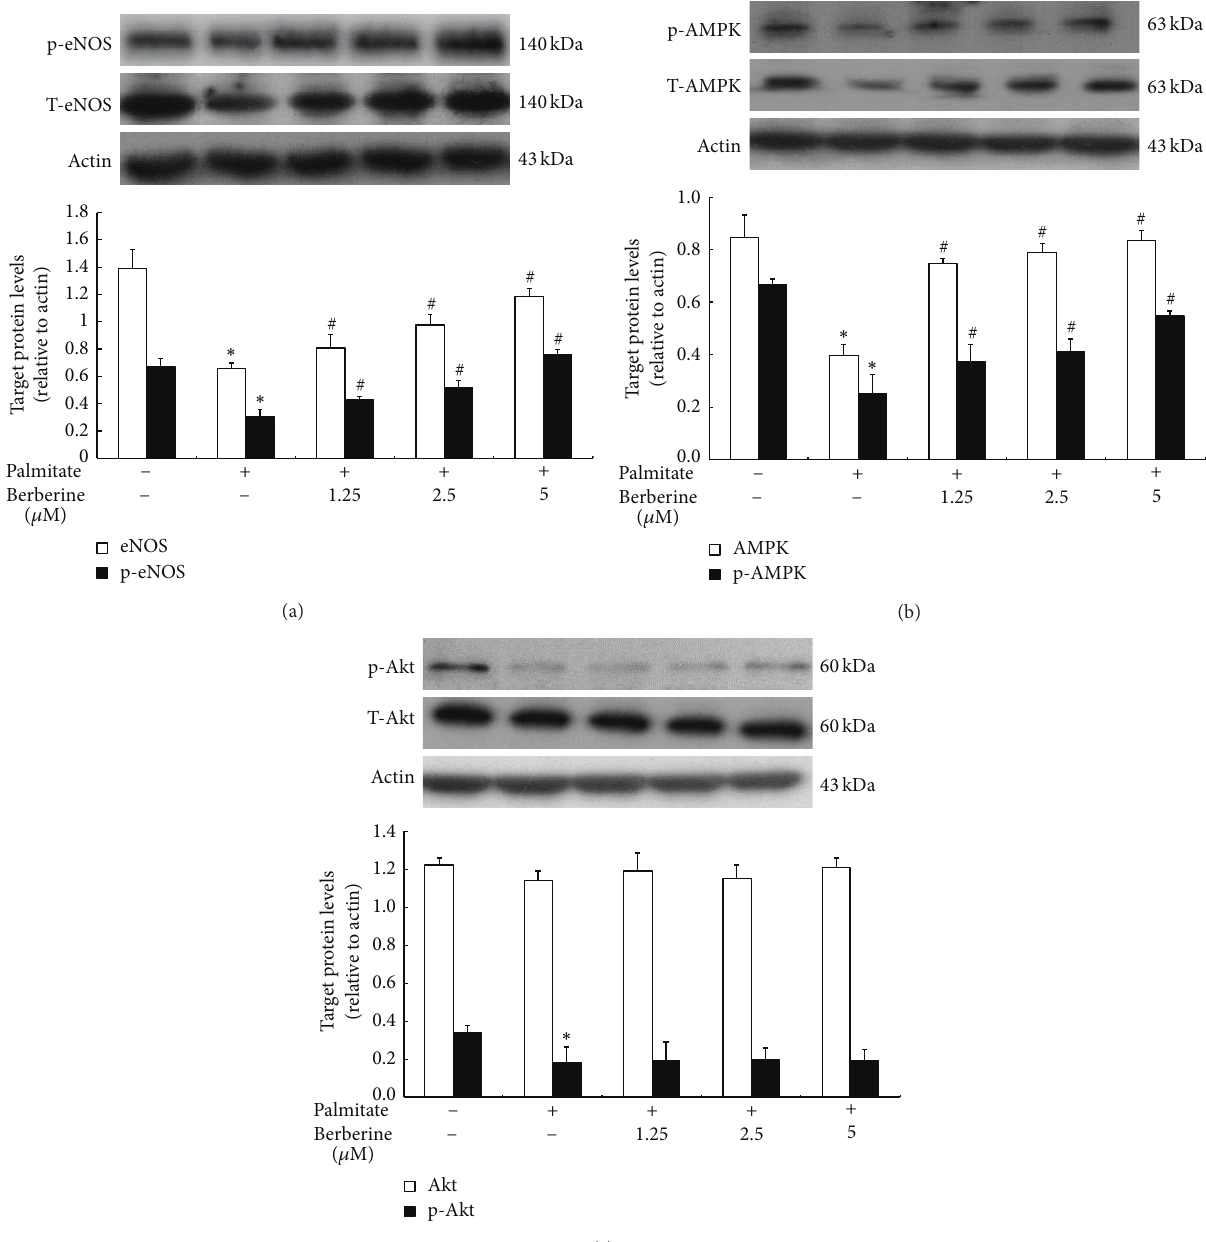
Figure 5: The effects of berberine on protein expression of eNOS, p-eNOS, Akt, p-Akt, AMPK, and p-AMPK in HUVECs exposed to palmi- tate. HUVECs were cultured in RPMI-1640 containing 0.5 mmol/L palmitate and treated with 1.25, 2.5, and 5 𝜇 mol/L berberine for 24h. Total protein was prepared and separated by SDS-PAGE. Expression and relative quantification of eNOS, Akt, and AMPK and phosphorylation of eNOS, Akt, and AMPK protein levels were expressed relative to the amount of actin. Control group was not stimulated with 0.5mmol/L palmitate. Data are mean ± S.E.M. All presented results are representative of at least 3 independent experiments. ∗ 𝑃 < 0.05 versus control group, # 𝑃 < 0.05 versus palmitate treated